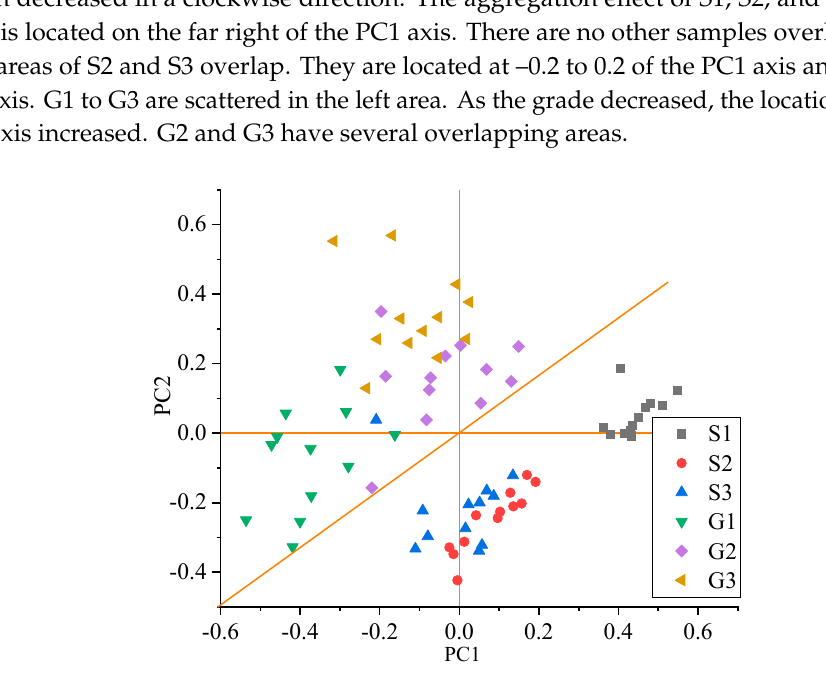
Figure 5. PCA plot of the combined signals of each tea grade.